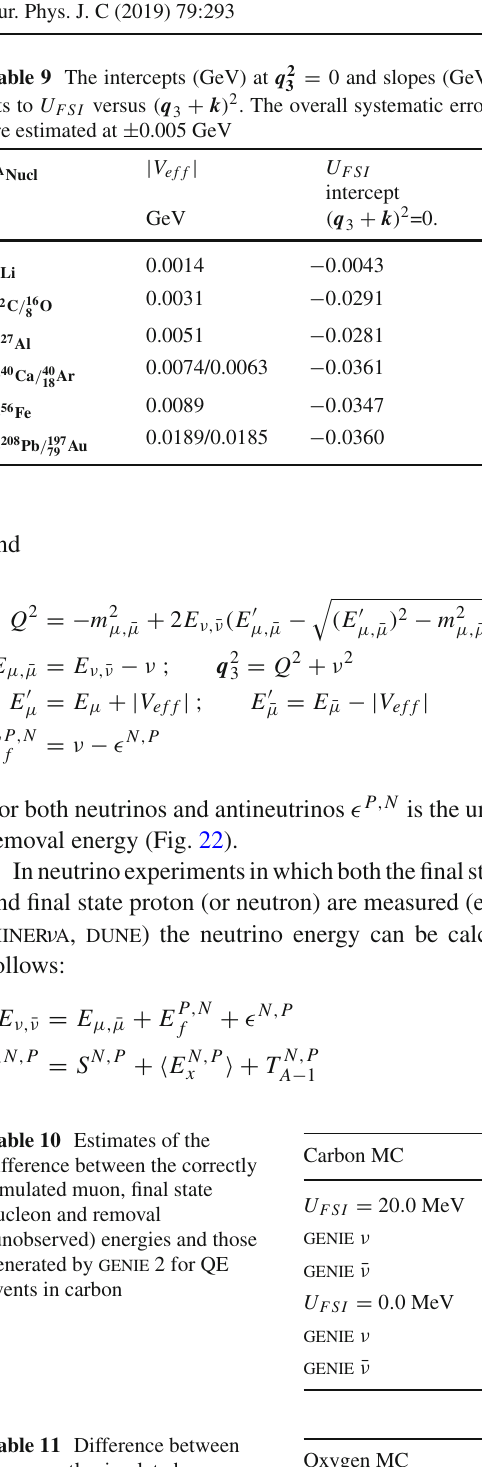
the correctly simulated muon, nucleon and removal (unobserved) energies and those generated by genie 2 for QE events in